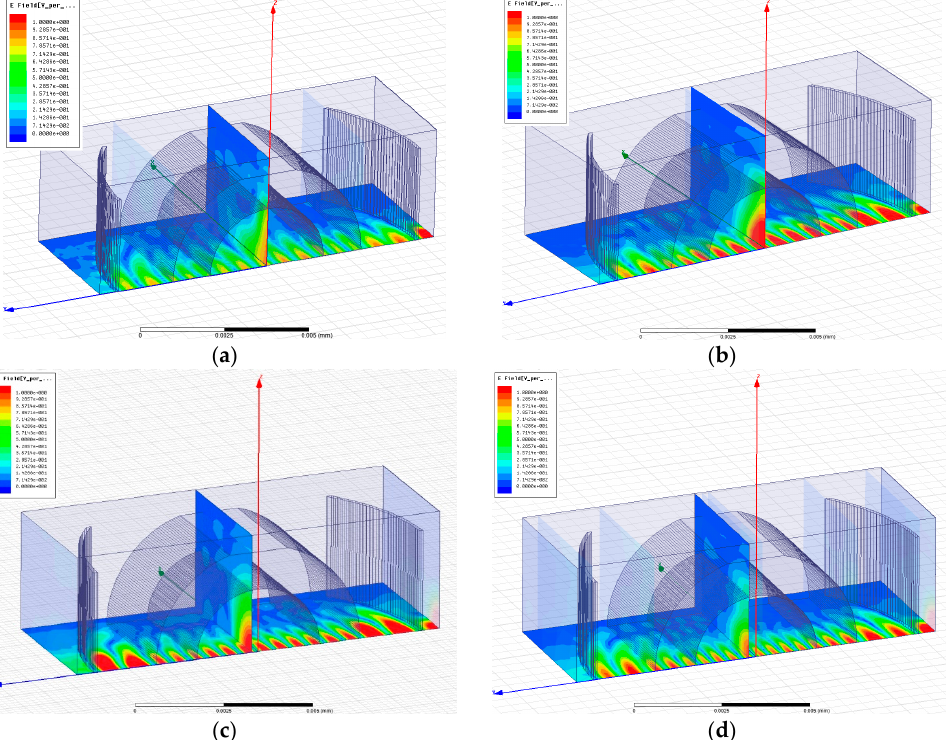
Figure 6. The electric field distribution at resonance for different test liquids ( a ) n t = 1.18, resonance at 1528 nm; ( b ) n t = 1.3, resonance at 1576 nm; ( c ) n t = 1.6, resonance at 1511 nm; ( d ) n t = 1.8, resonance at 1505.7 nm.